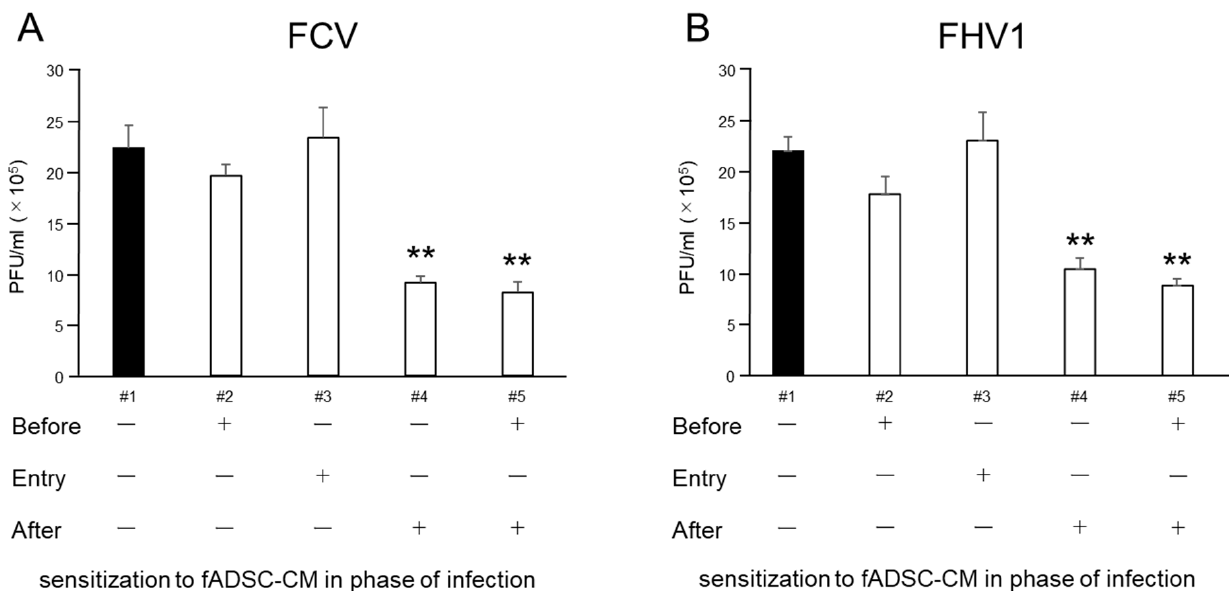
Figure 6. Comparison of virus titers measured in PFU in the supernatant of infected CRFK cells sensitized with (+) or without (-) fADSC-CM at different infection phases. Virus titers of FCV ( A ) and FHV1 ( B ). Data are expressed as the mean ± standard deviation. Asterisks indicate significant differences compared with mock-treated group (**, p < 0.01).